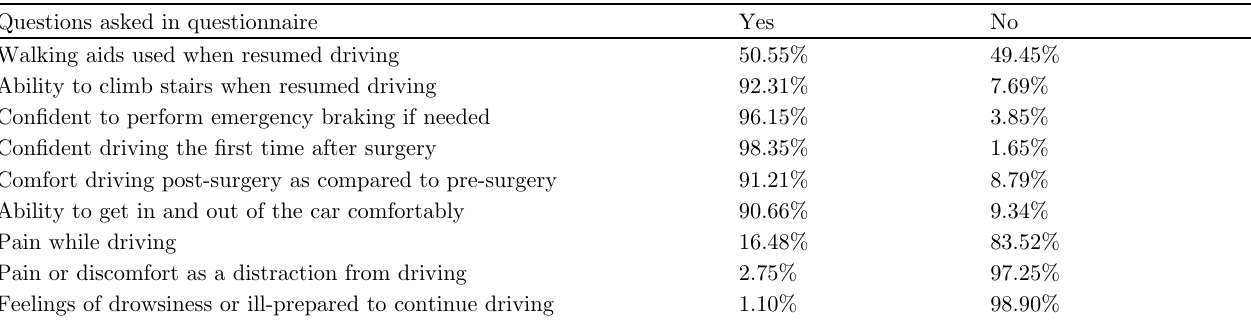
Table 2. Patient responses to driving